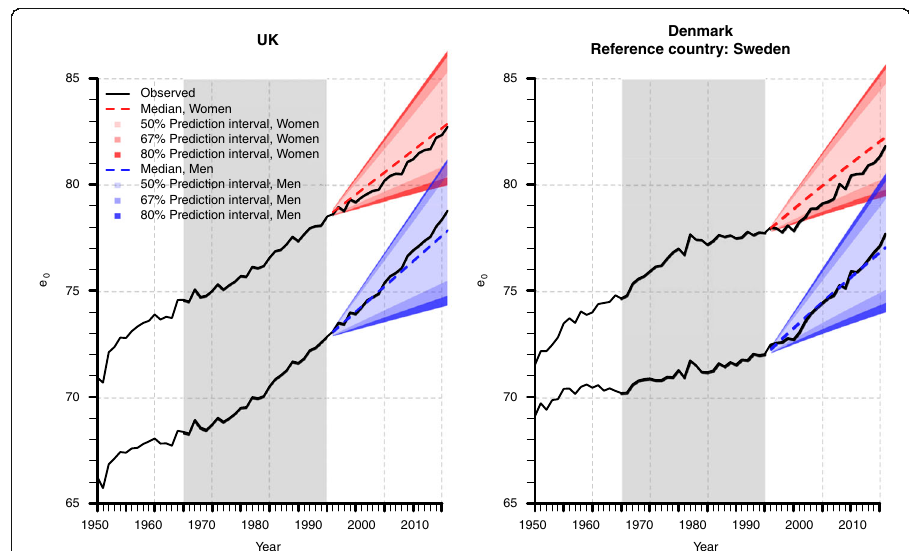
Fig. 2 Observed ( black ) and forecasted life expectancy ( e 0 ) of our model for British ( left ) and Danish ( right ) women ( red ) and men ( blue ); increasing forecast uncertainty is represented by the widening 80, 67, and 50% prediction intervals, whose colors become brighter from the outside to the median ( dashed line ). In this validating forecast, we take the data from 1965 to 1990 ( gray colored box ) as basis to forecast mortality from 1991 to 2011. Moreover, in the Danish forecasts, we combine the mortality trends of Denmark and